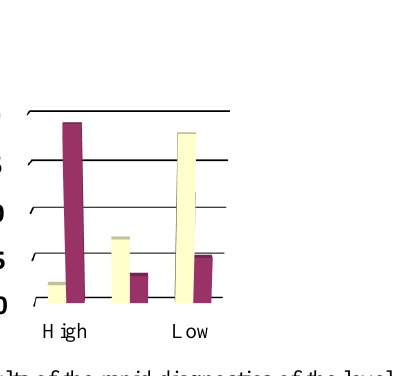
Figure 2. Rapid diagnosis of the level of social isolation of the individual in the experimental and control groups